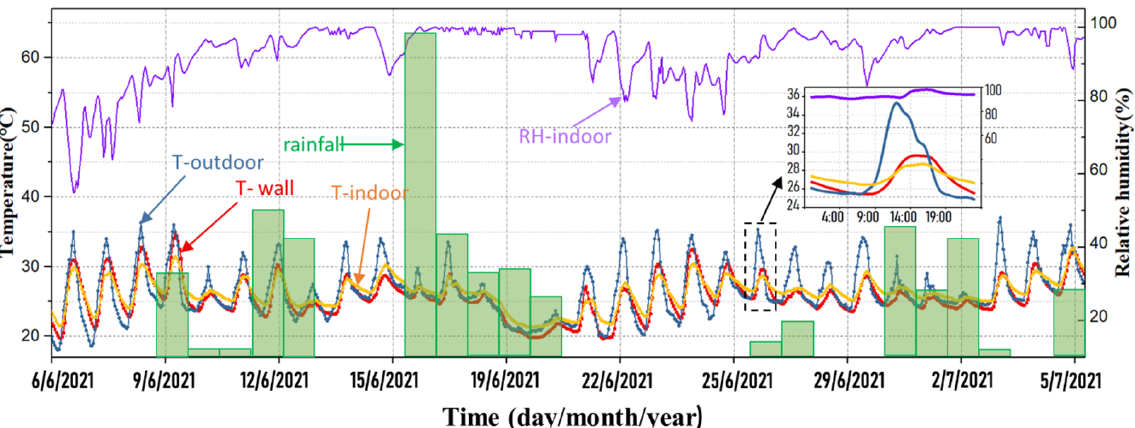
Figure 7. Temperature and relative humidity inside and outside the stone house (6 June 2021–5 July